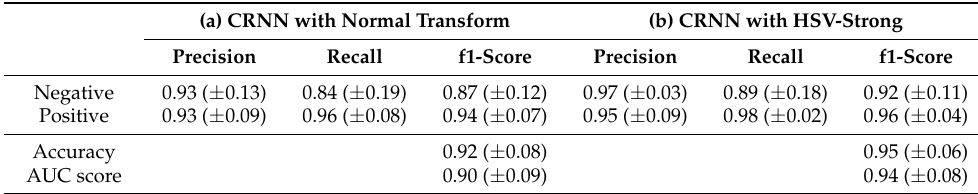
Table 2. Results of TERT mutation prediction on the CRNN (ResNet152 + LSTM) model showing the mean and standard deviation values following five-fold cross-validation.